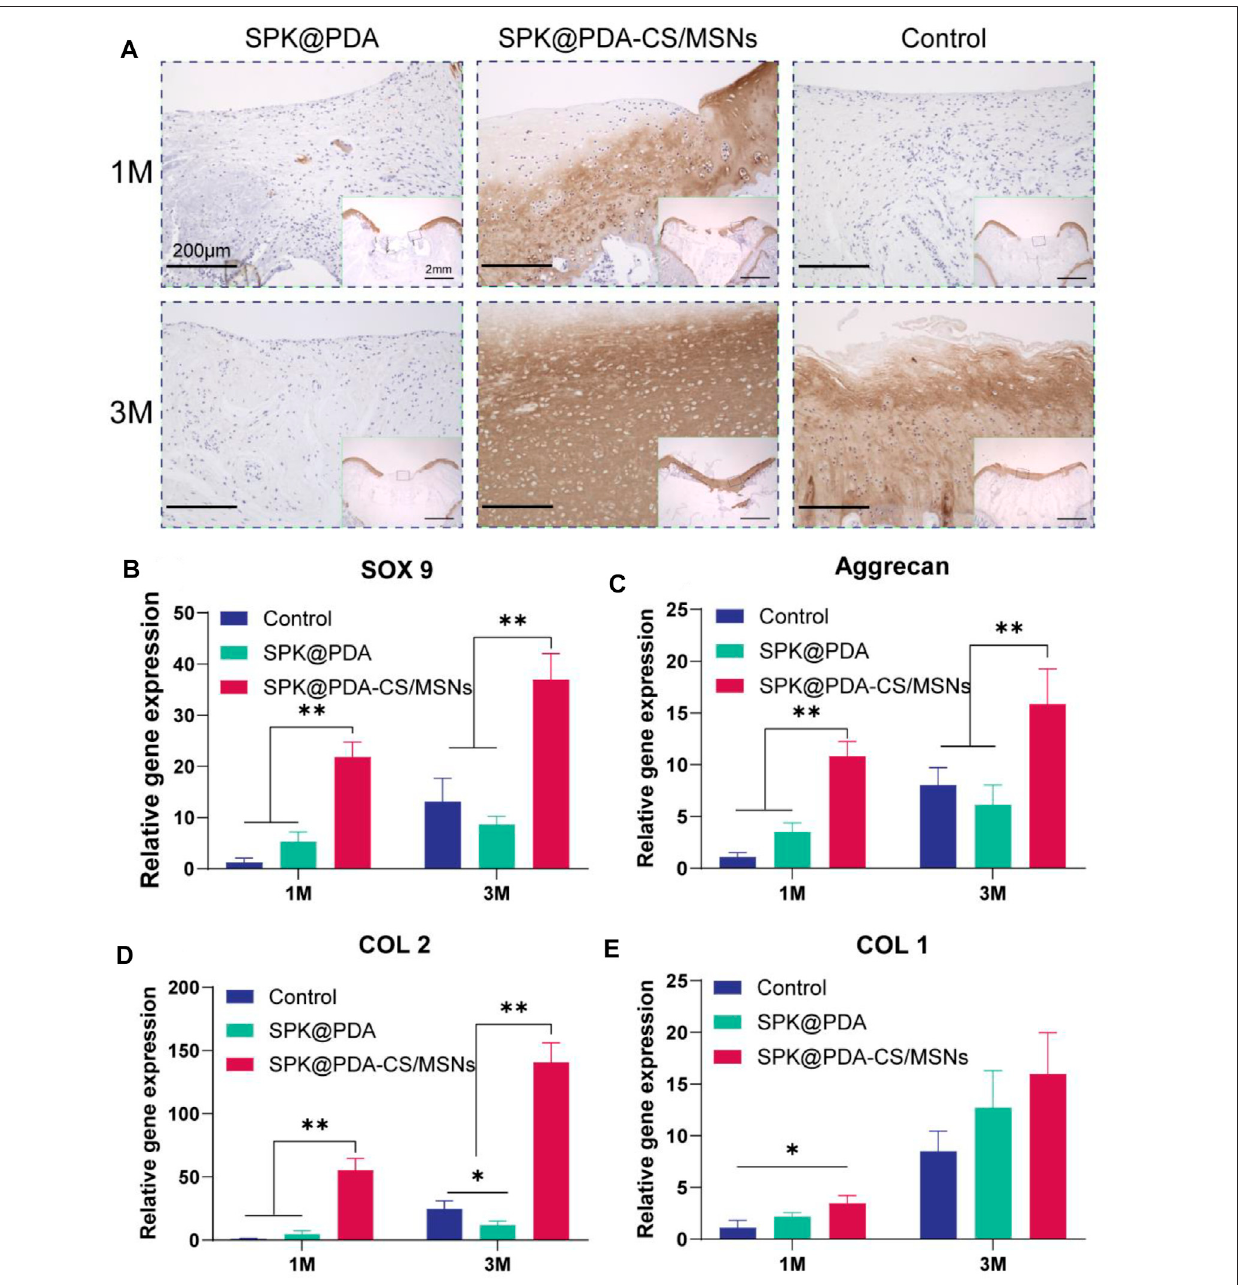
FIGURE 7 | Immunohistochemical staining and RT-PCR analysis for cartilage repair. (A) Immunohistochemical staining with collagen II of the repaired tissue at 1 and 3 months after surgery. (B – E) Expression of related genes, SOX9 (B) , aggrecan (C) , collagen II (D) , and collagen I (E) of the repaired tissue at 1 and 3 months after surgery. Data are showed as mean ± SD, n = 3. * p < .05, ** p < .01.